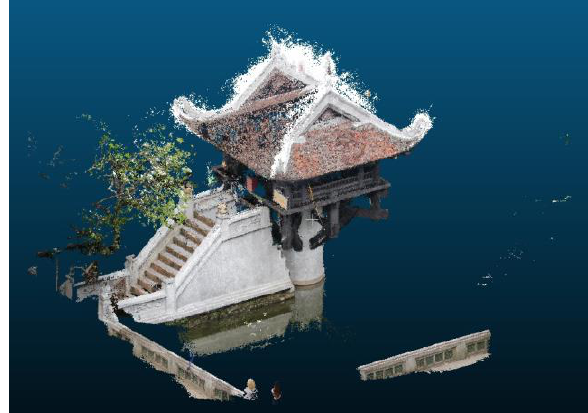
Figure 4. Point cloud from SURE